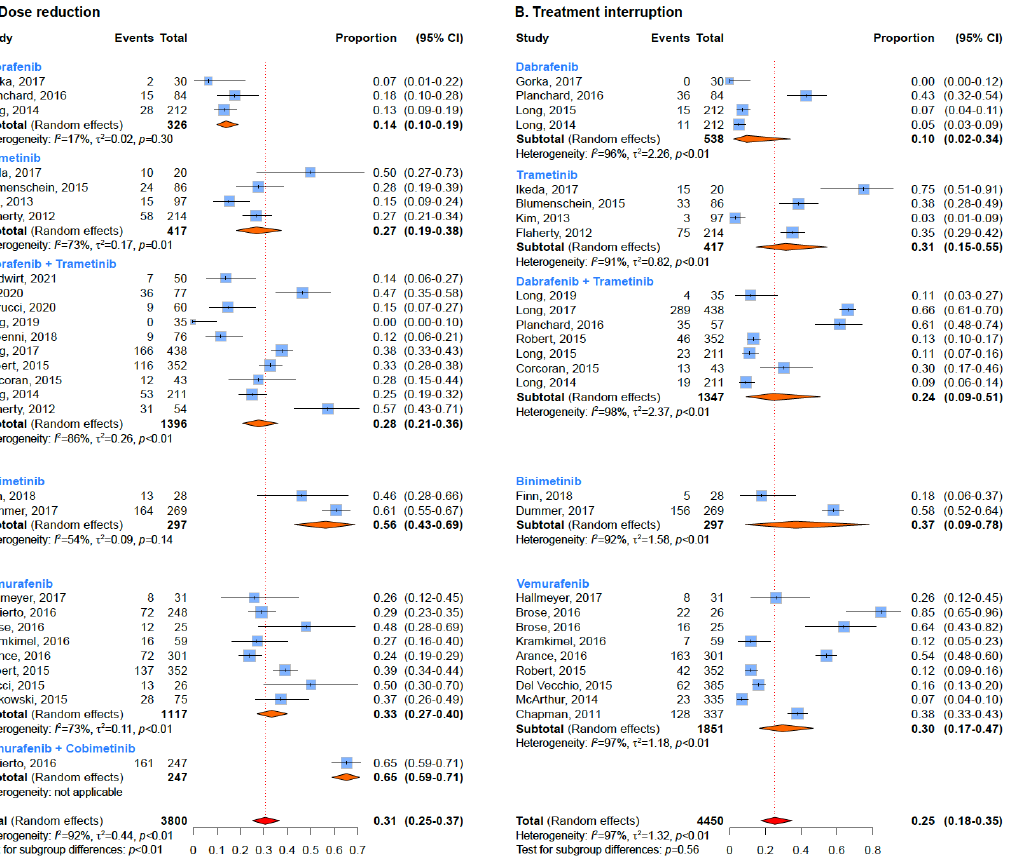
Figure 6. Summary estimates of dose reduction ( A ) and treatment interruption ( B ) according to treatment regimen.